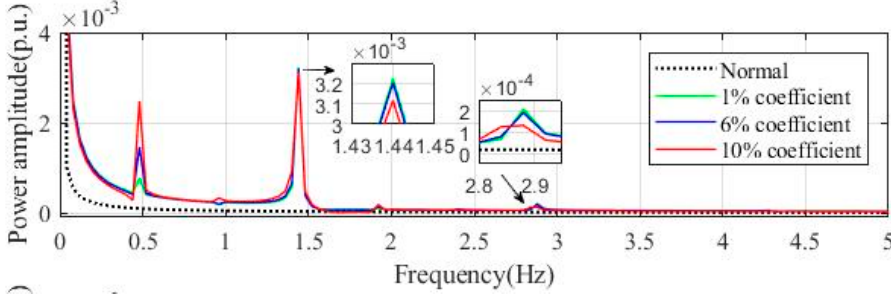
Figure 13. Electromagnetic power spectrum under b = 1%, 6%, and 10% state.